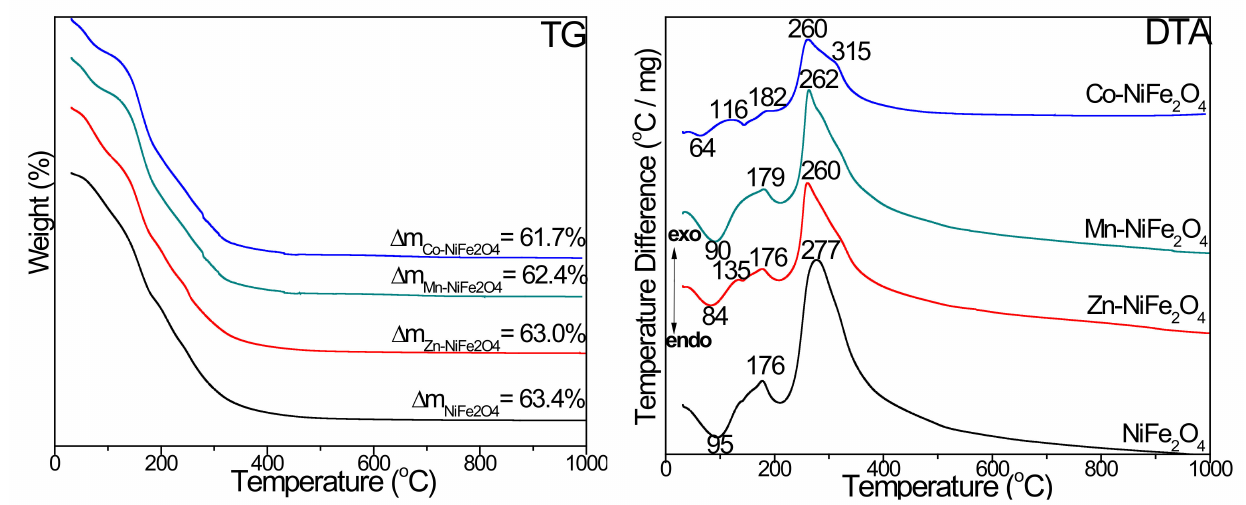
Figure 2. TG and DTA curves of virgin and doped NiFe 2 O 4 (Zn-NiFe 2 O 4 , Mn-NiFe 2 O 4 , Co-NiFe 2 O 4 ) dried at 40 ◦